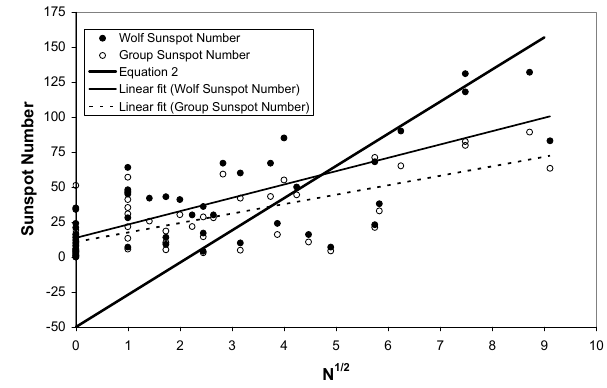
Fig. 1. Relationships between the sunspot numbers and the square Figure 1. Relationships between the sunspot numbers and the square root of N . Equation (2) is root of N . Equation (2) is also shown. showed too.